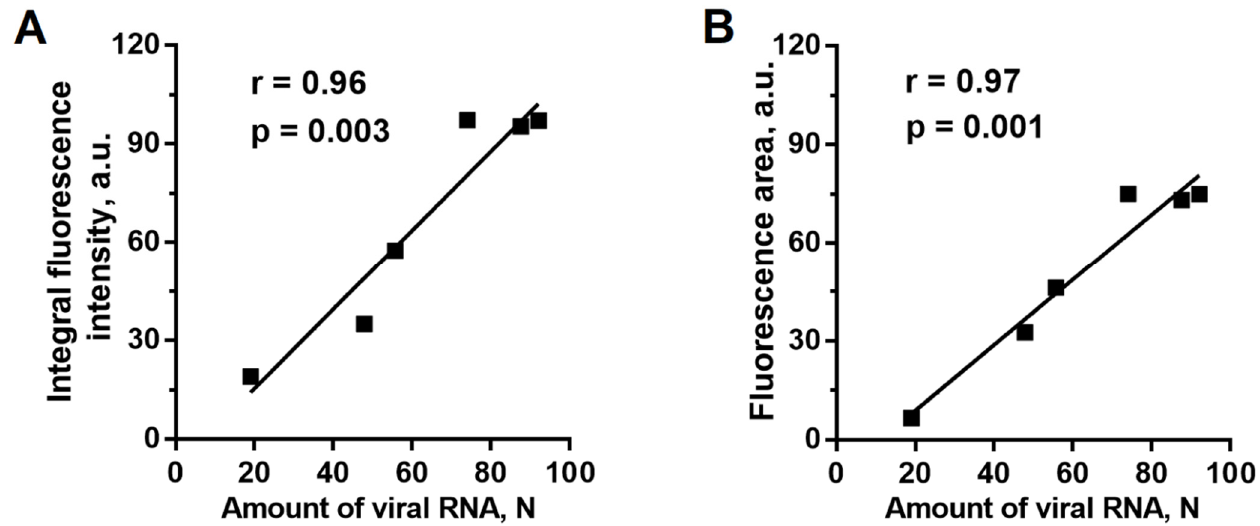
Figure 2. Correlation of the integral fluorescence intensity of PVX-GFP ( A ) and the fluorescence area ( B ) versus the viral RNA amount ( n = 6). N is an arbitrary unit equal to 2 − Ct × 10 4 . The Ct values are shown in Table S1.